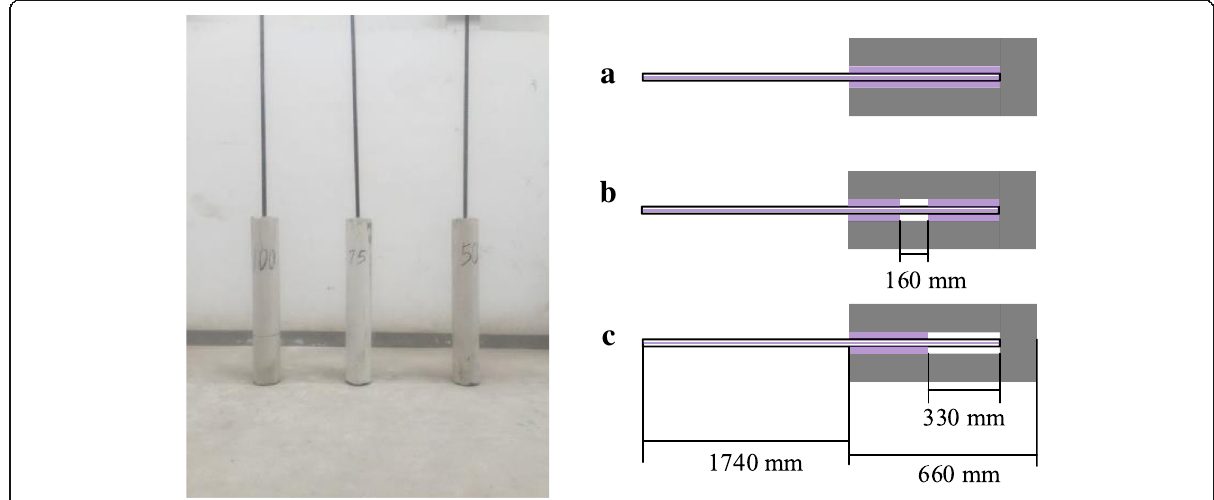
Fig. 4 The schematic diagram for the anchorage body with different defect length (unit: